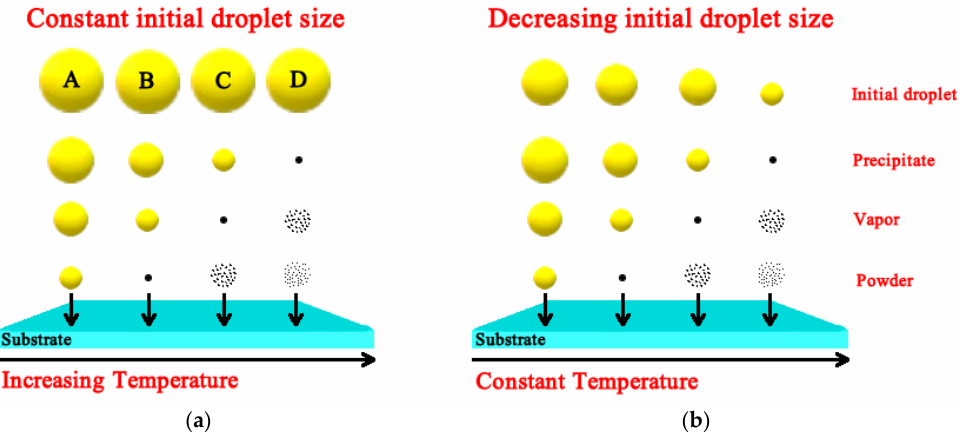
Figure 2. Diagram of the different process stages for the aerosol droplet evolution as it approaches the hot substrate for two cases: ( a ) Constant initial droplet size and increasing substrate temperature, and ( b ) constant substrate temperature and decreasing initial droplet size.